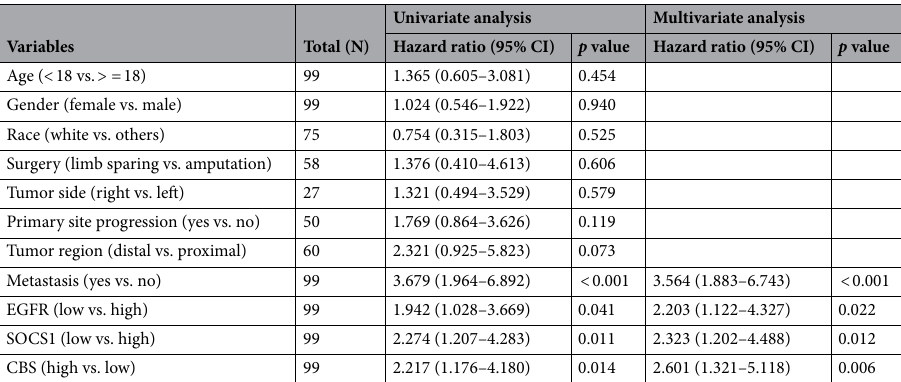
Table 3. Cox regression analyses of overall survival for OS